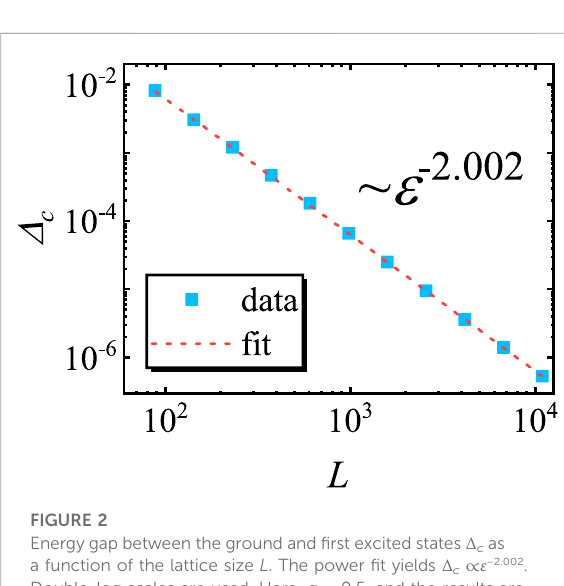
FIGURE 2 Energy gap between the ground and fi rst excited states Δ c as a function of the lattice size L . The power fi t yields Δ c ∝ ε − 2.002 . Double-log scales are used. Here, g = 0.5, and the results are averaged for 100 choices of ϕ